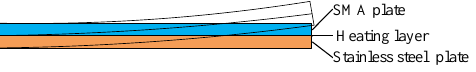
Figure 12. Schematic of active morphing skin.